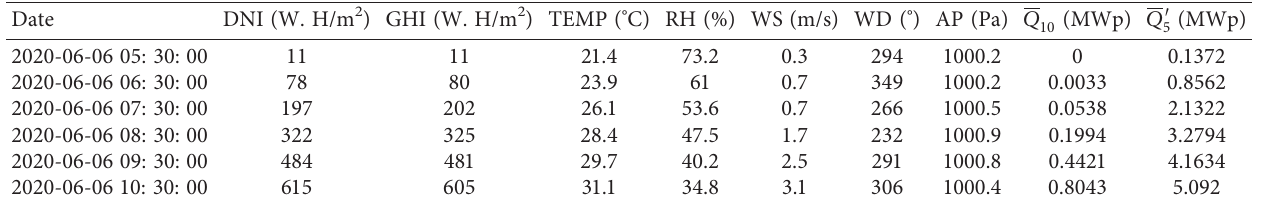
Table 2: Part of sample data after sorting.